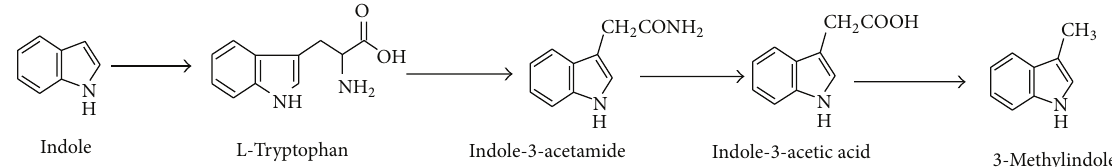
Figure 4: Pathway of indole transformation by Lysinibacillus xylanilyticus strain